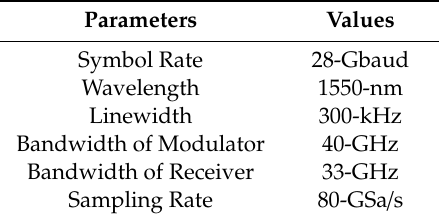
Figure 1. Experimental setup. Table 1. Summary of the key physical parameters in experimental setup.